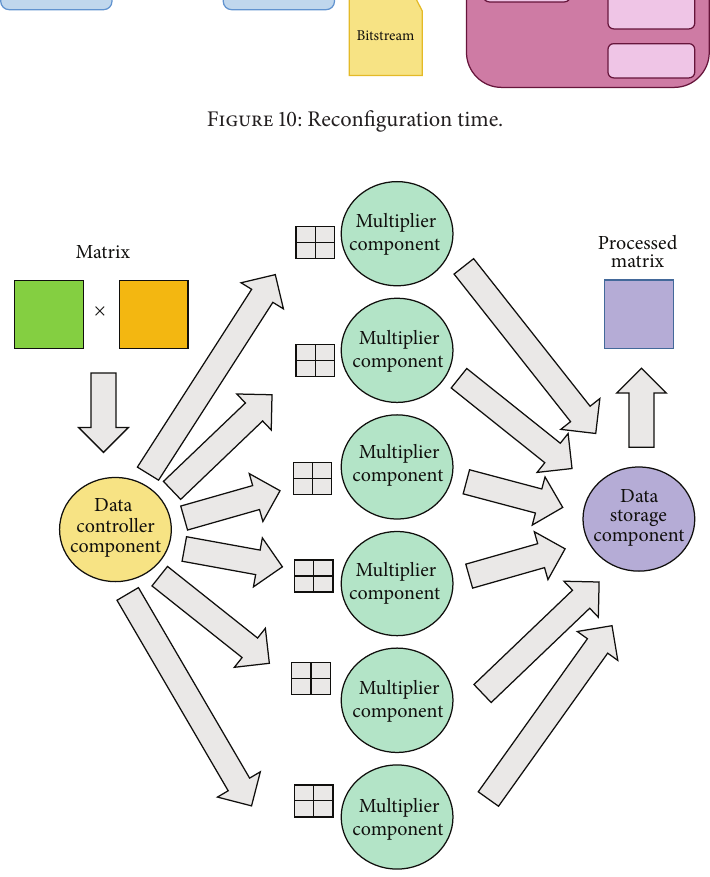
Figure 11: Logical architecture defined for the experiment. These three roles compose the logical architecture where the number of processing elements (multipliers) is